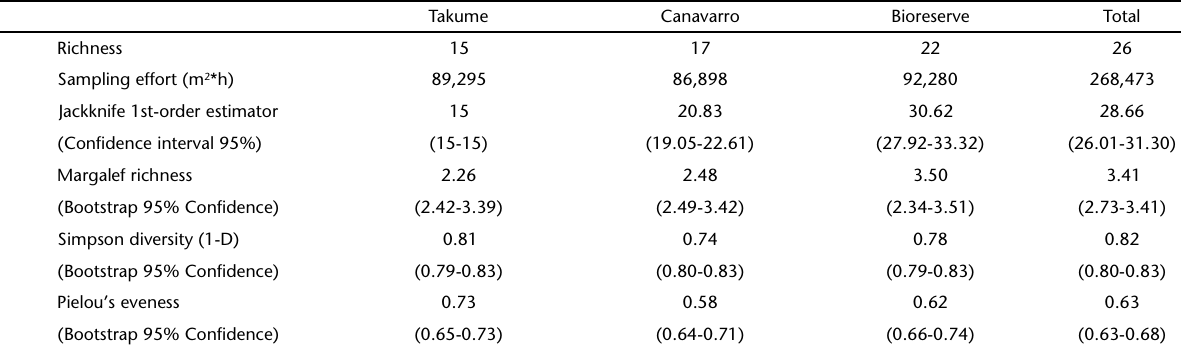
Table II. Sampling effort and ecological index in the areas of the buffer zone and Tinguá Biological Reserve, state of Rio de Janeiro. Takume Canavarro